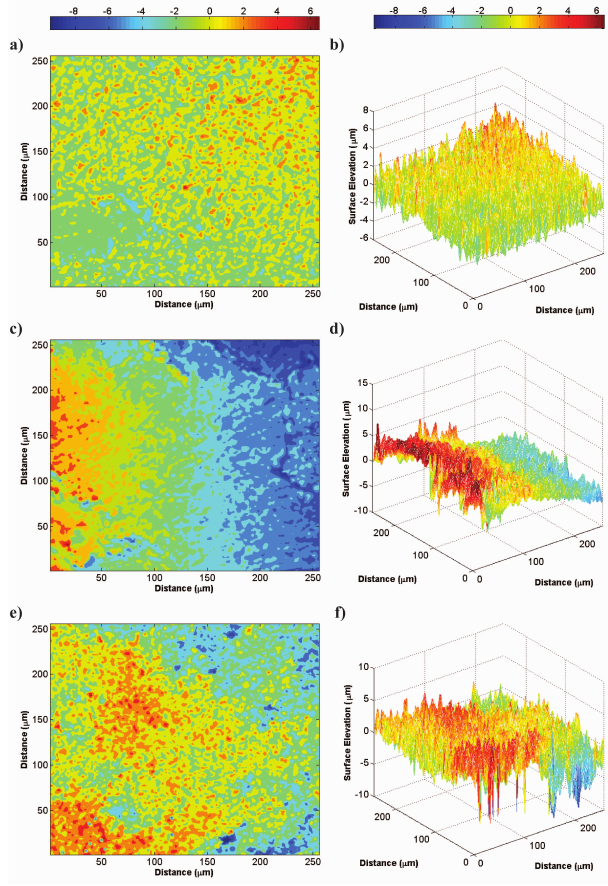
Figure 8. MATLAB-generated contour maps and topographic nets based on data from laser scanning of grain surfaces under micro- scope. Topographic variations ( z axis) are illustrated by a common colour scale used for all images. Data sets are normalised to the mean topographic elevation; positive z axis values therefore corre- spond to relief greater than the mean. All maps represent a 256µm by 256µm area on the olivine surface. (a + b) Phenocrystic olivine, (c + d) mantle olivine and (e + f) Igwisi Hills lava olivine.